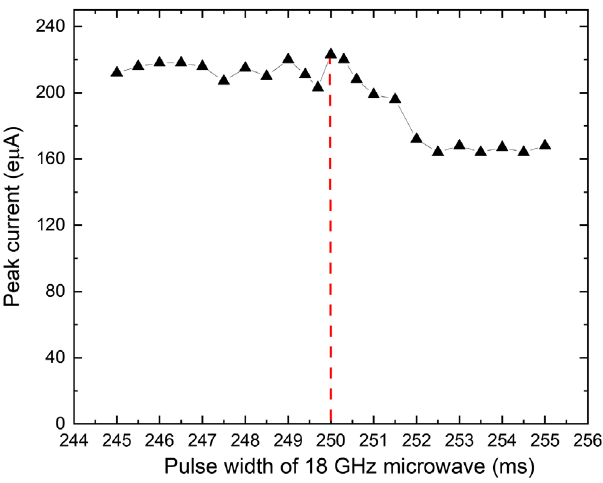
FIG. 6. Peak current of Xe 34 þ afterglow beams with varied 18- GHz microwave pulse width. The pulse width of the 24-GHz microwave is set to 250